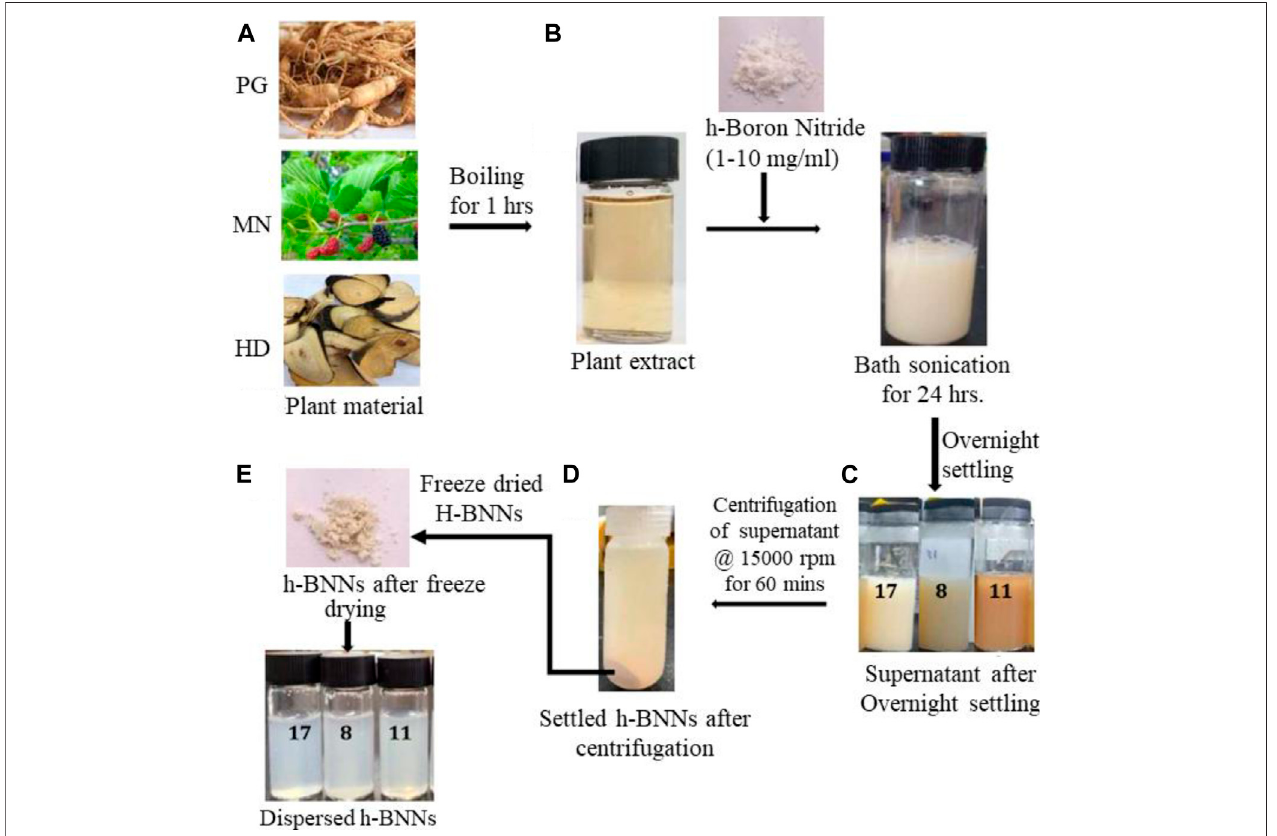
FIGURE15| Schematicdiagramofthebiogenicexfoliation ofbulkh-BNtoh-BNnanosheets usingplantmaterialextractofPanaxginseng(PG),Morusnigra(MN) and, Hoveniadulcis (HD). The fi gure is reprinted with permission from Deshmukh et al., 2019, Copyright 2019, American Chemical Society.